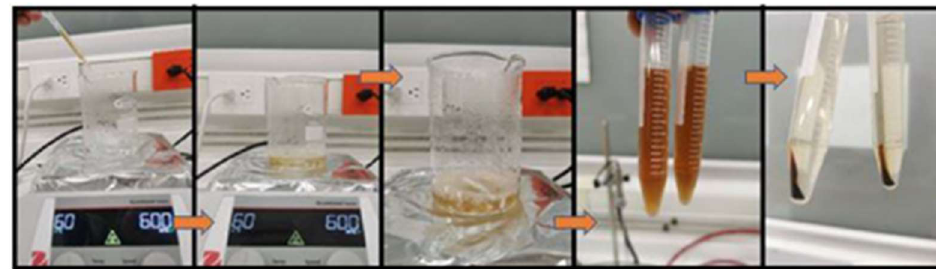
Figure 2. Reagent mixing process for the synthesis of AgNPs.